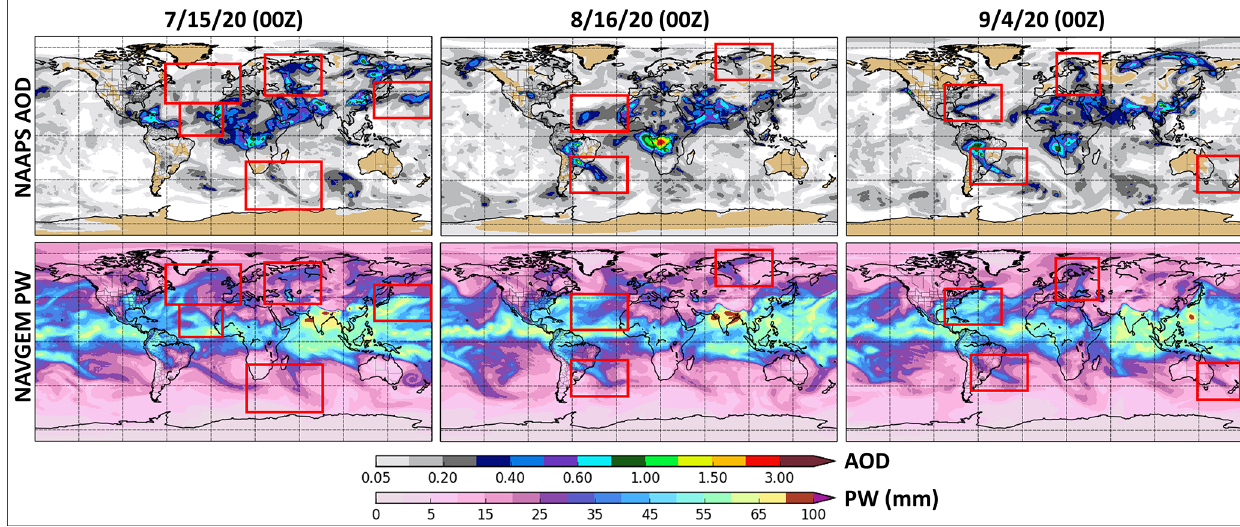
Figure 1. Examples of NAAPS AOD and NAVGEM PW forecasts in which similar synoptic-scale transport patterns are found, particularly in the midlatitudes. Aerosol and water vapor features with similar transport patterns are highlighted in matching red boxes in the AOD and PW plots. These types of co-transport events of both positive and negative correlation are found in forecasts on a daily